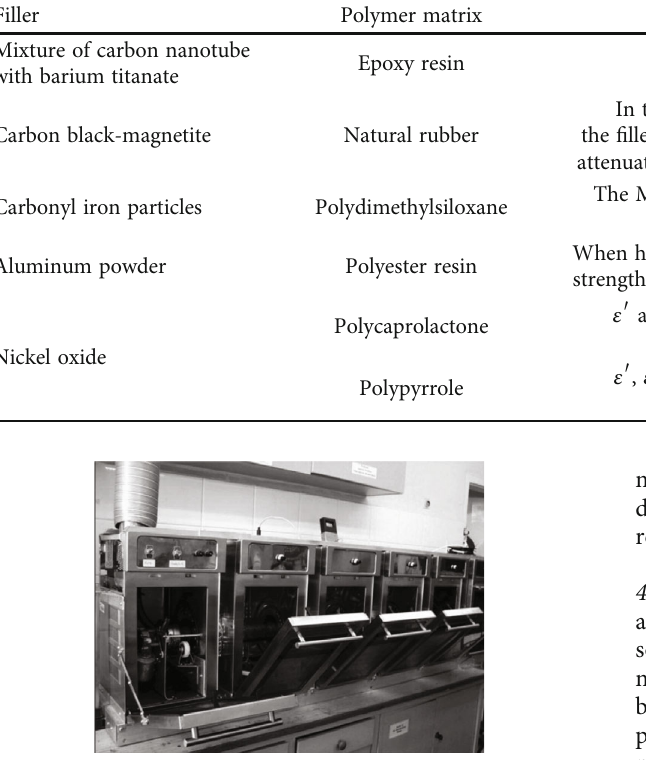
Table 3: Fillers used for indirect microwave heating of some polymers, with the improvements observed. Filler